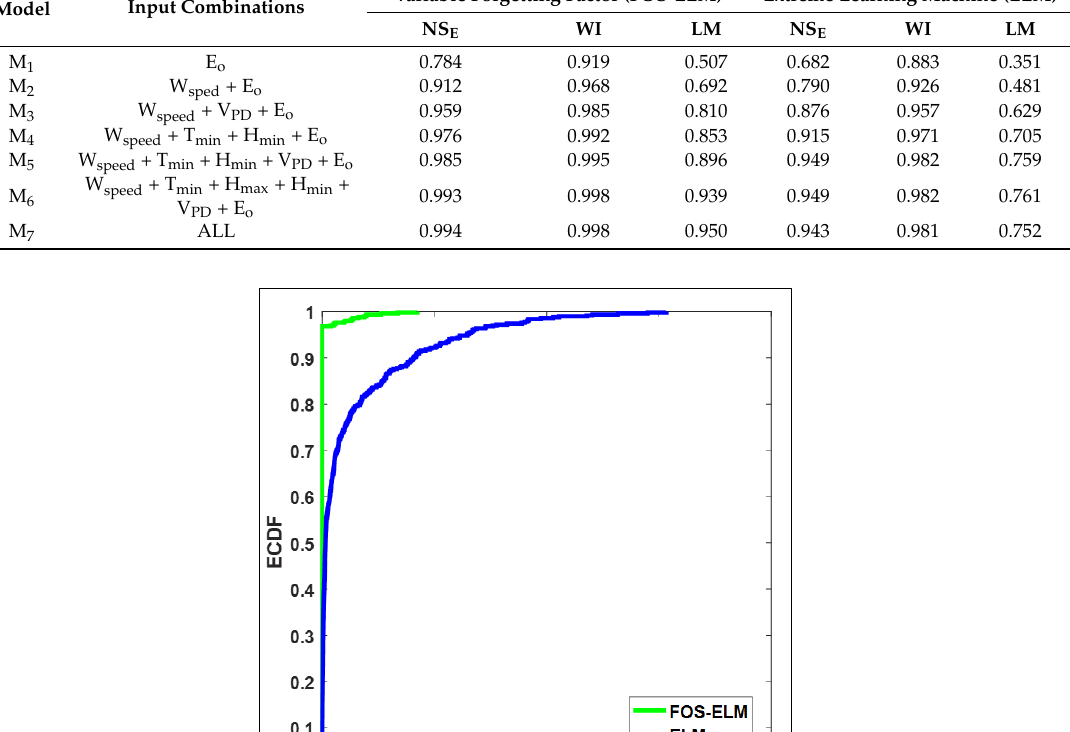
Table 2. Test modeling phase performance of FOS-ELM and ELM models using all the reported metrics. Note, the best model is boldfaced.